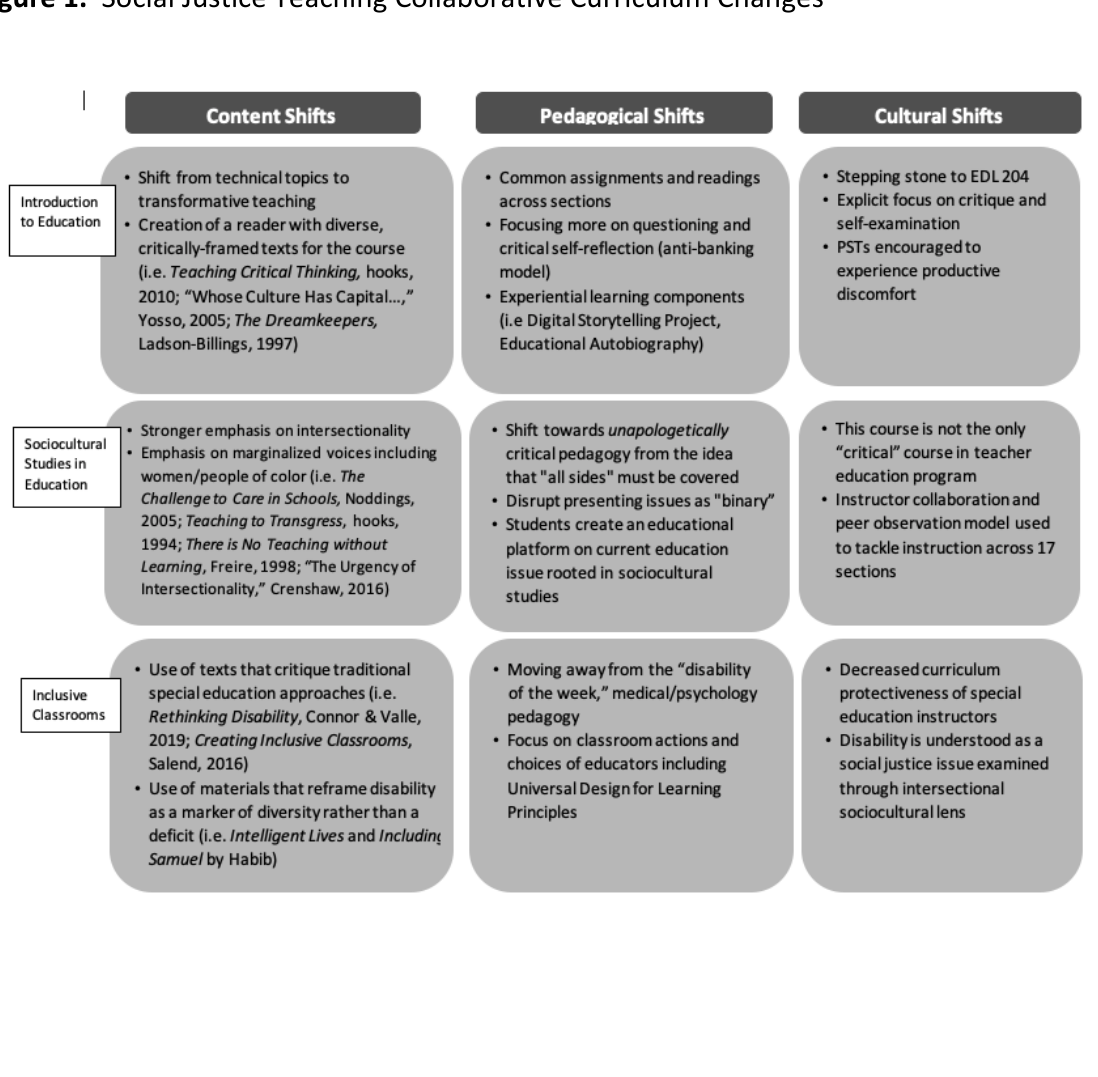
Figure 1. Social Justice Teaching Collaborative Curriculum